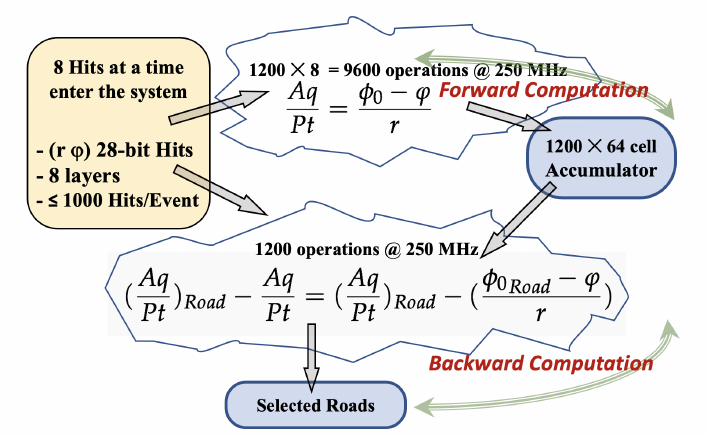
Figure 4. Forward and Backward